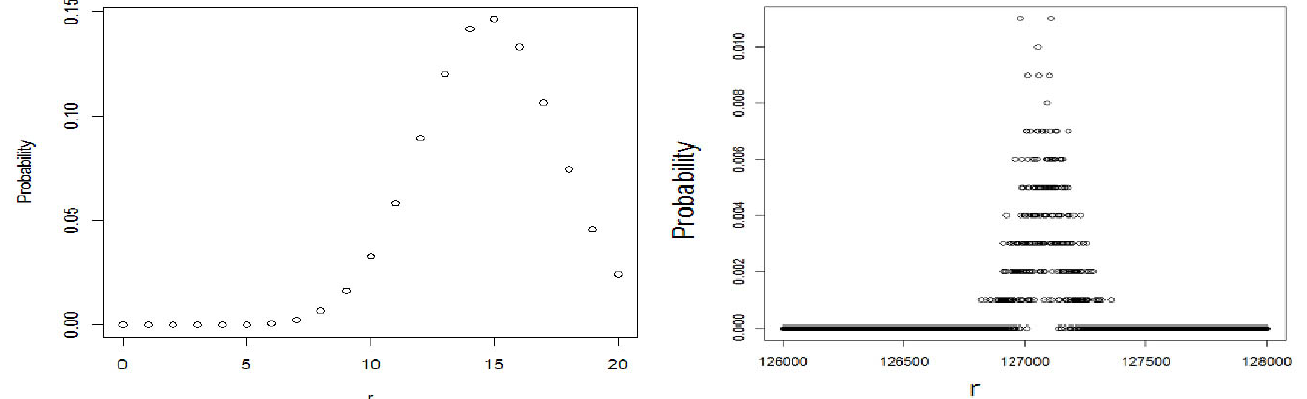
Fig. 7. Simulated distribution of r , based on 1 000 simulated data sets with p = 1 052 420 and L = 135